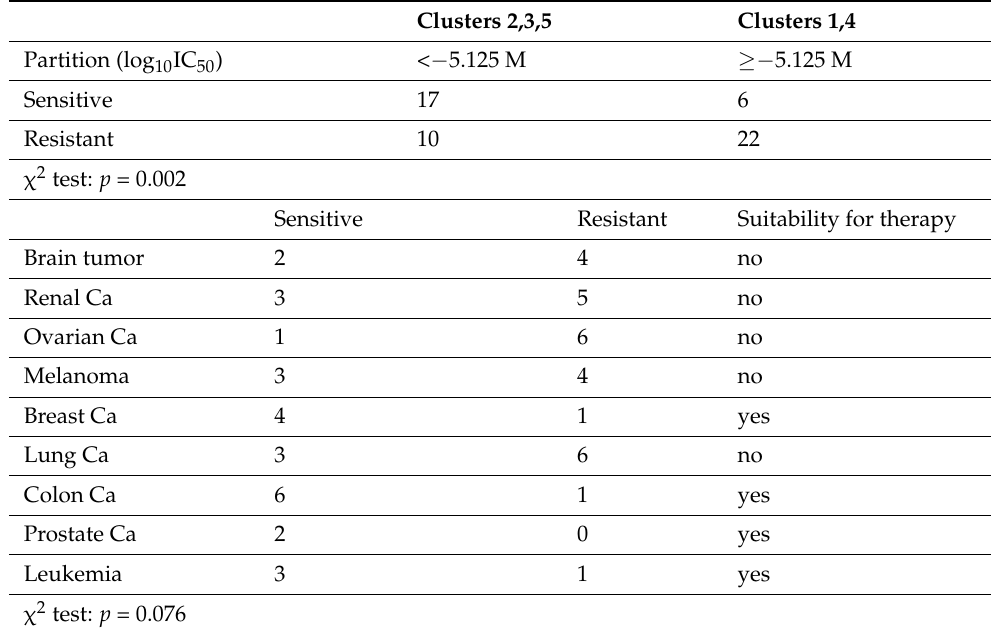
Table 4. The separation of the clusters with cell lines derived from different tumor types is shown in Figure 6 according to their gedunin sensitivity or resistance using the χ 2 test.